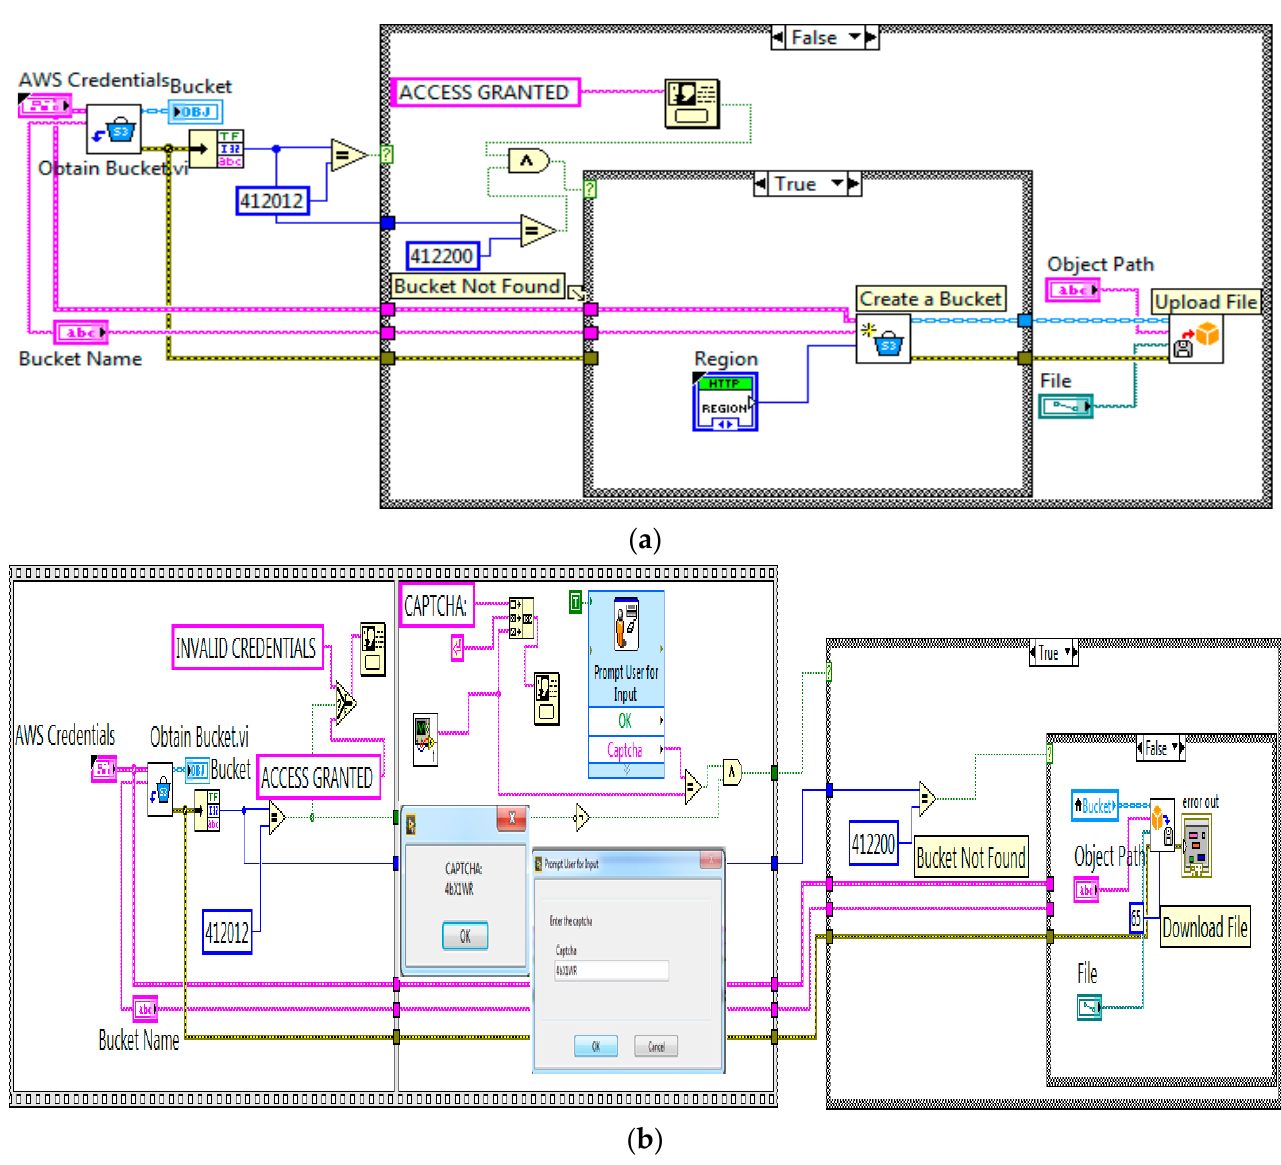
Figure 4. ( a ) Block diagram view: Storing ciphered image in S3 bucket. ( b ) Block diagram view: Retrieving ciphered image from S3 bucket with three-tier authentication.